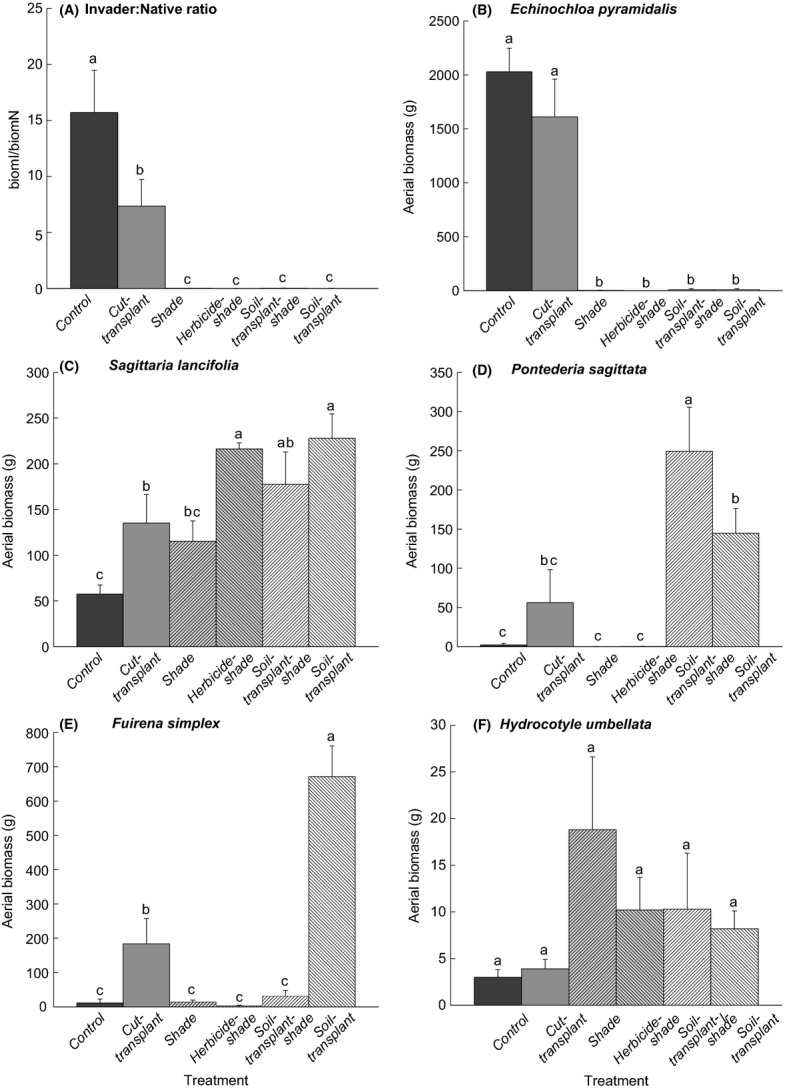
Ratio response for biomI/biomN and aerial biomass (mean + 1SE; n = 7) for five dominant hydrophytes under six different treatments in the La Mancha freshwater wetland. Harvesting took place in dry season, 19 months after the treatments were applied. Different letters indicate significant differences among means (two-way ANOVA; P < 0.05).